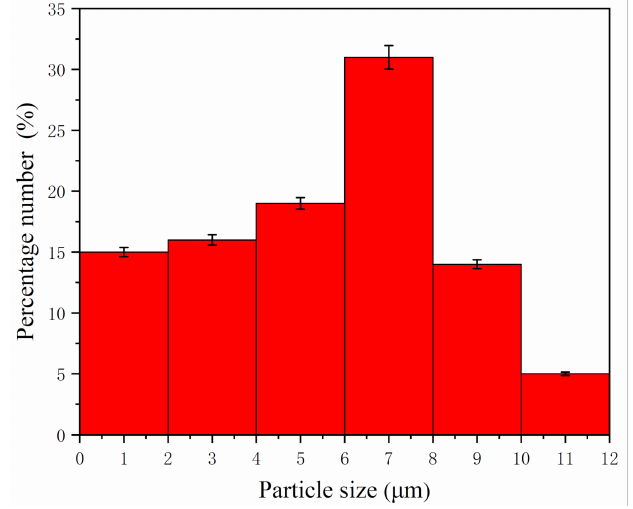
Figure 3. Particle size distribution of microcapsules prepared at 600